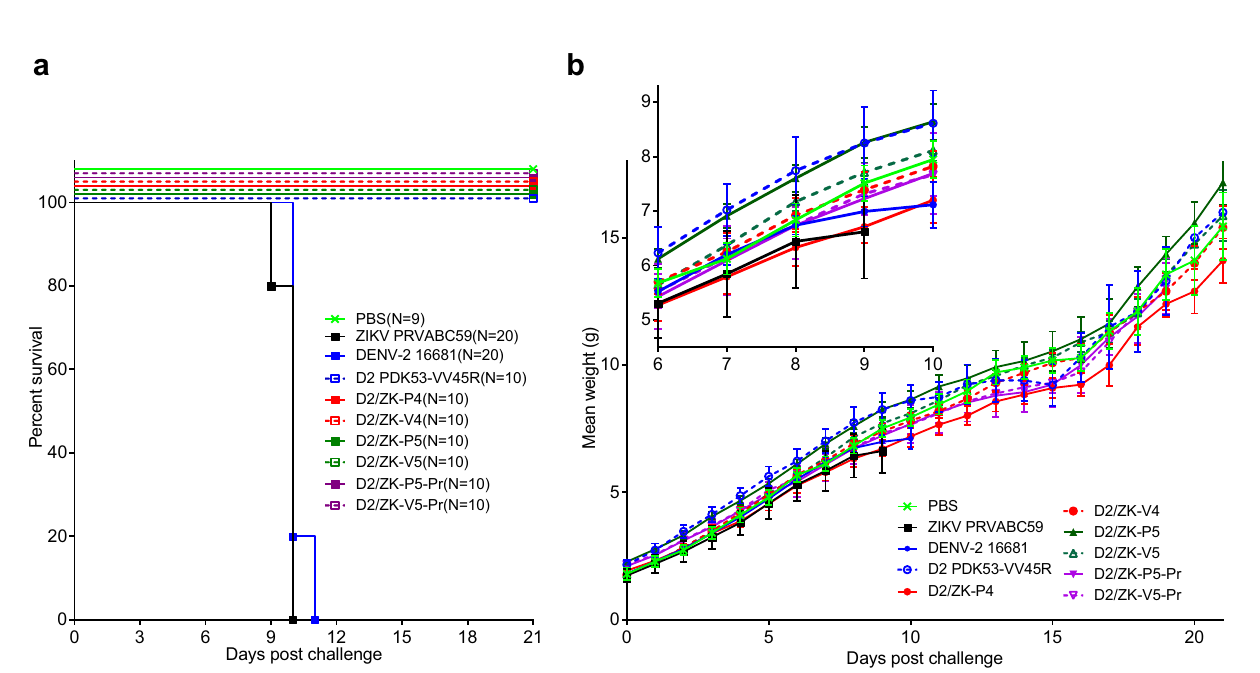
Fig. 5 Chimeric viruses are non-neurovirulent in neonatal CD-1 mice. a Kaplan – Meyer survival curves of 1-day-old CD-1 mice inoculated i.c. with 10 4 pfu of virus. b Group mean weight ±SD post virus challenge. Inset fi gure shows a close-up of the graph between 6 and 10 days post challenge. The number ( n ) of mice in each virus group is indicated in the symbol legend of fi gure a